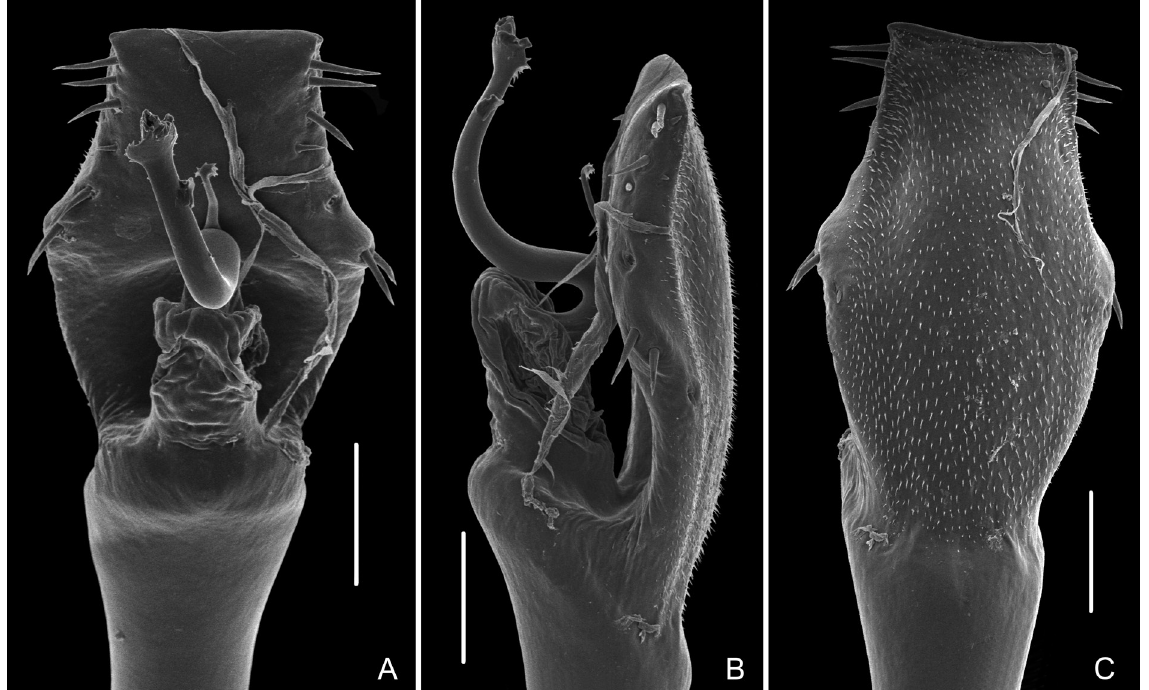
Fig. 8. Amazochroma pedroi gen. et sp. nov. (MNRJ 2352). ♂, genitalia, distal part. A . Dorsal view. B . Lateral view. C . Ventral view. Scale bars = 100 μm.